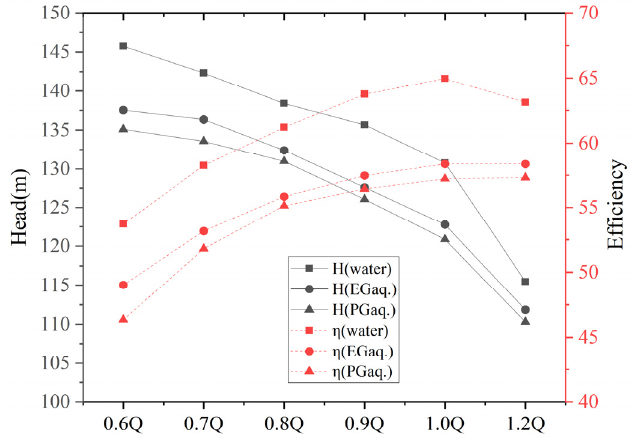
Figure 10. Characteristic curves of the pump with cylindrical blades.